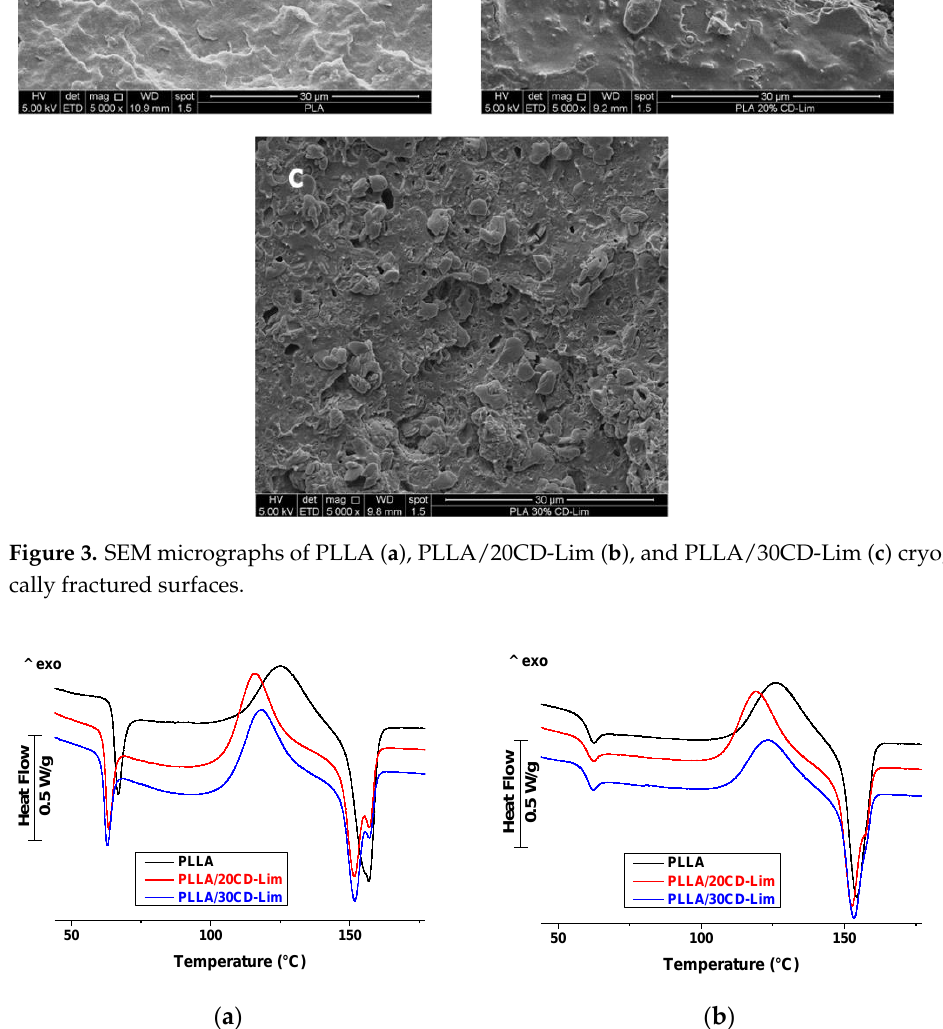
Figure 4. Heat flow rate plots of PLLA and PLLA/CD-Lim composites upon heating at 10 °C min −1 : ( a ) heating scan of the compression-molded sheets and ( b ) heating scan of the same samples after cooling at 10 °C min -1 . Exotherm upward.